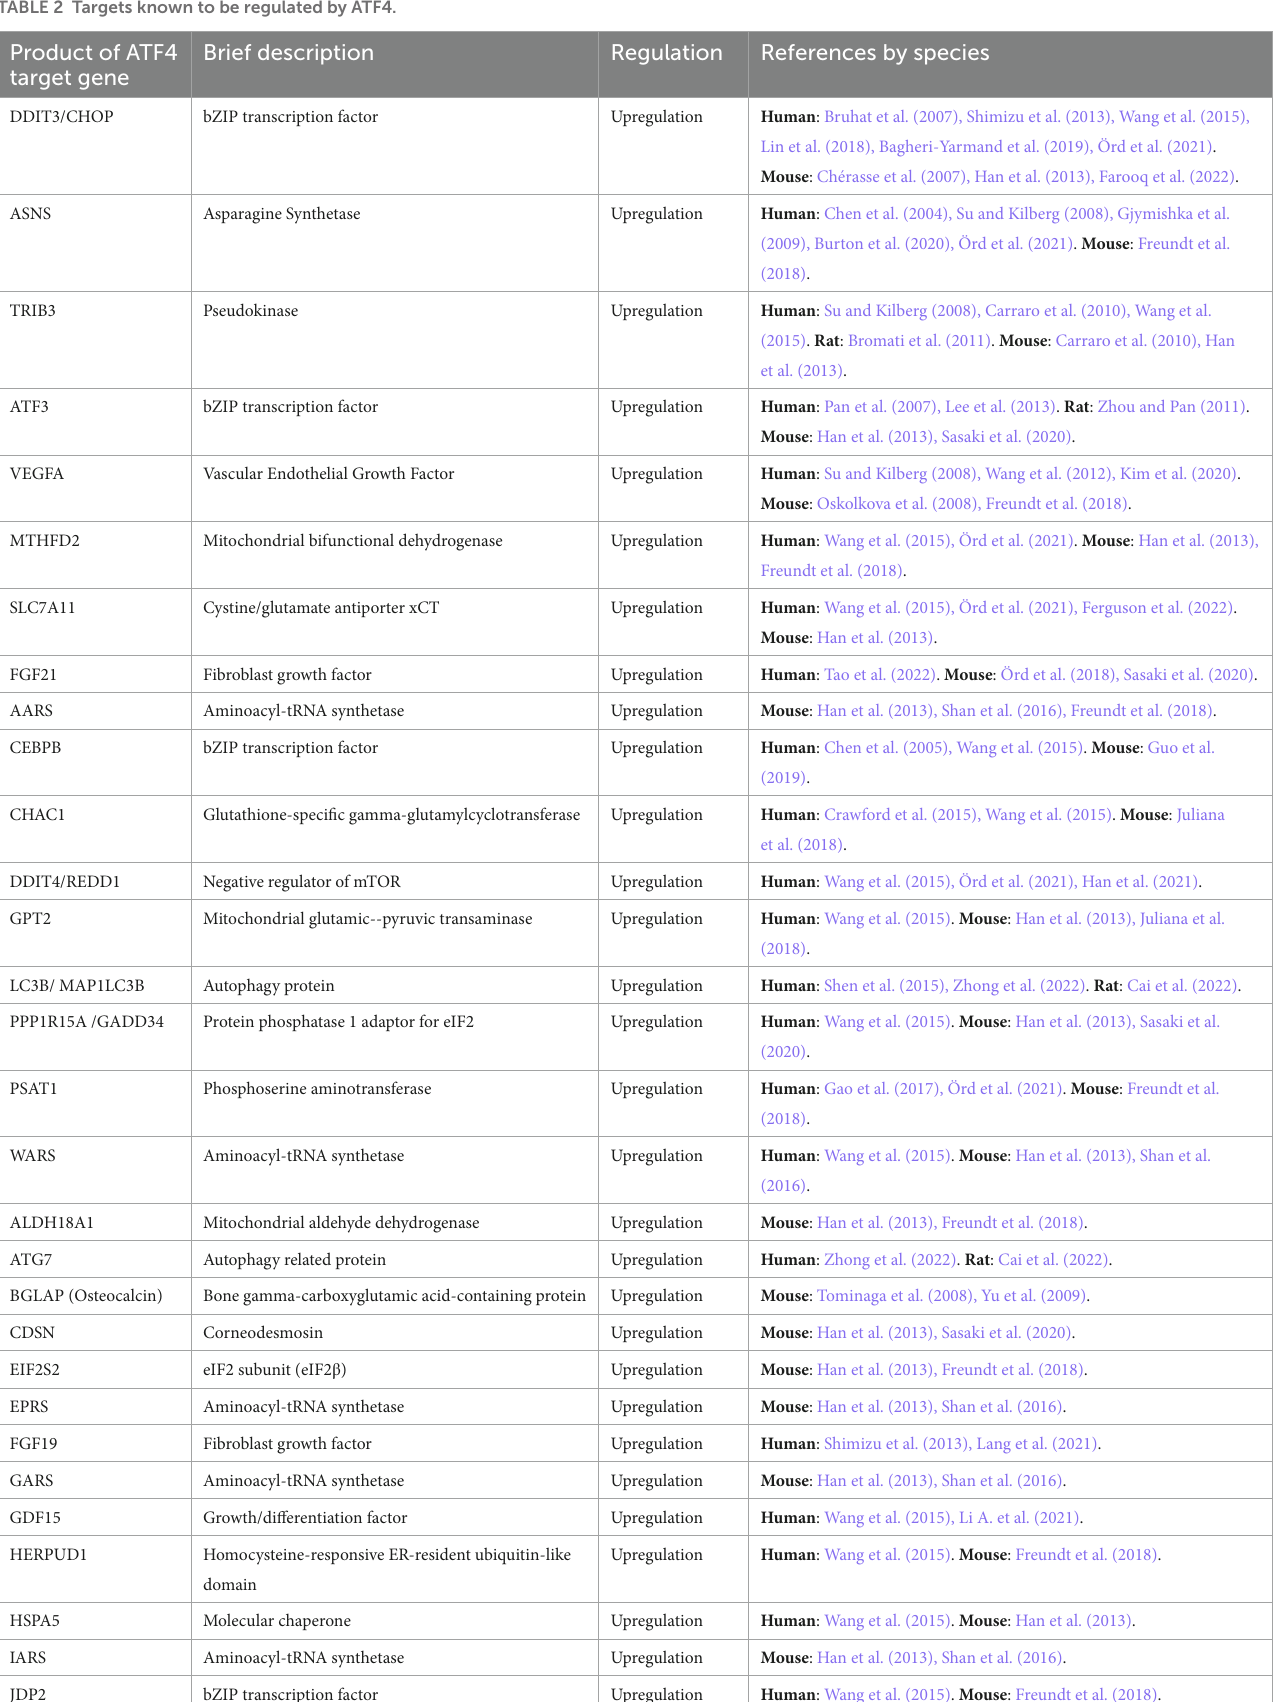
TABLE 2 Targets known to be regulated by